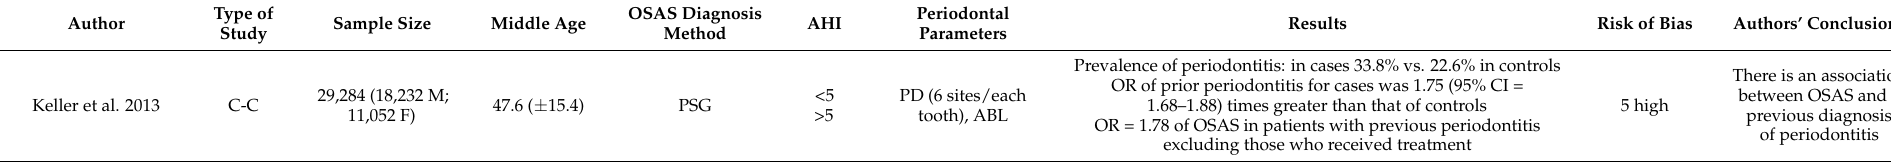
Table 1. Data extracted from the included studies. C-C: a case-control study, CS: cross-section study. pro-Matrix MetalloPeptidase 9, MMP-8: Matrix MetalloPeptidase 8,